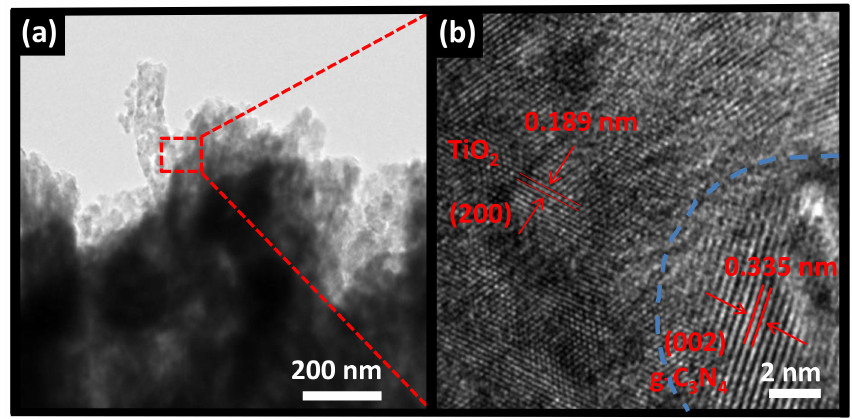
Figure 3. ( a ) TEM and ( b ) HRTEM images of heterostructured CNT6 composite.